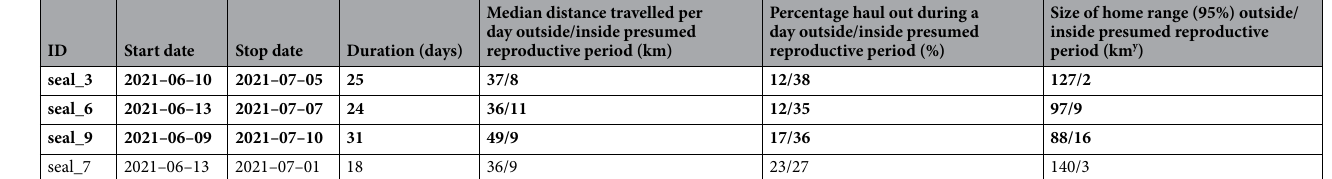
Table 3. Table showing the three female (bold) and one male individual exhibiting a shift in behaviour during the reproductive period. Presumed start and stop dates of the behavioural change were inferred from the behavioural data of each animal.